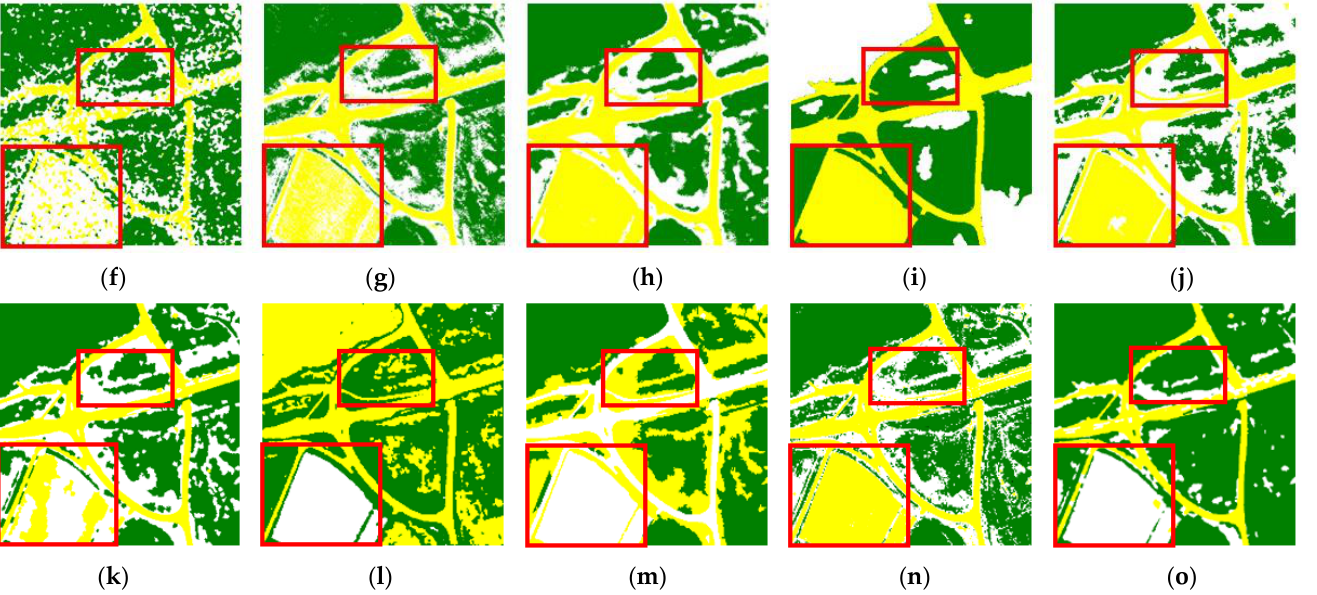
Figure 5. Experiment results of S2 images. The red rectangle boxes are selected as the comparison areas. ( a ) S2 K-means, ( b ) S2 ISODATA, ( c ) S2 FCM, ( d ) S2 IFCM, ( e ) S2 FLICM, ( f ) S2 HMRF-FCM,